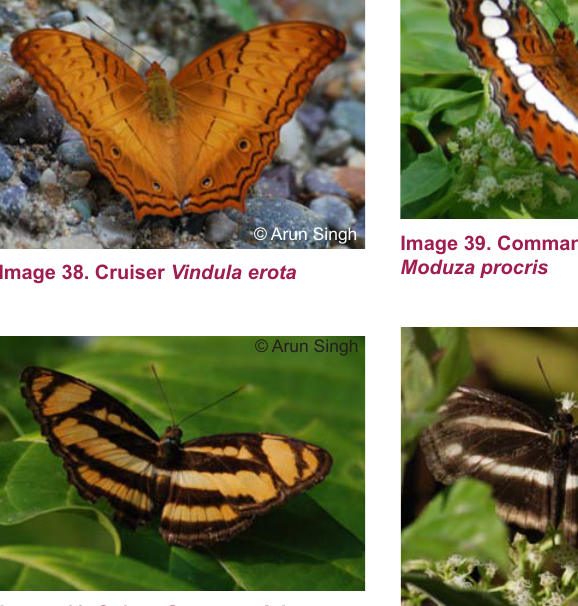
Image 41. Colour Sergeant Athyma nefte (male)